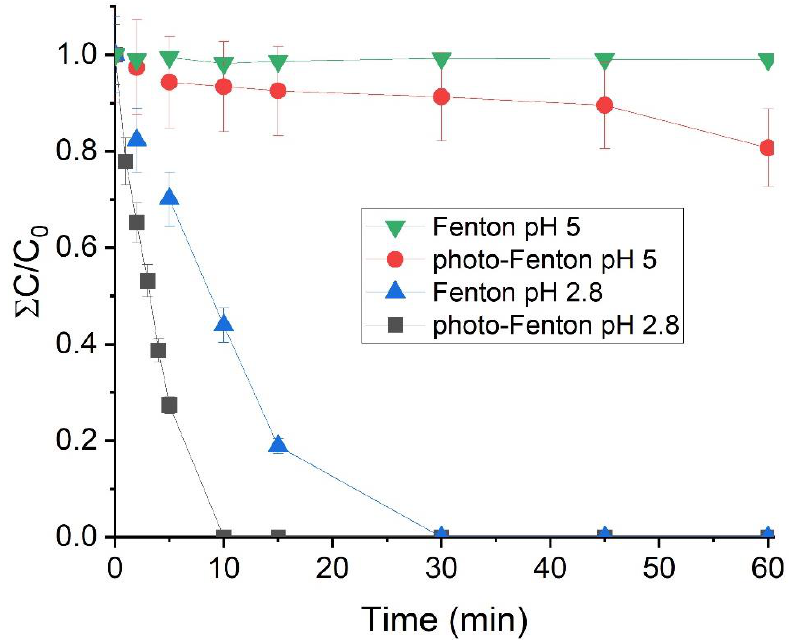
Figure 1. Paraben degradation by Fenton and photo-Fenton processes at optimal pH 2.8 and at pH 5. [methylparaben] = 5 mg · L − 1 , [ethylparaben] = 5 mg · L − 1 , [propylparaben] = 5 mg · L − 1 , [butylparaben] = 5 mg · L − 1 , [benzylparaben] = 5 mg · L − 1 , [H 2 O 2 ] = 26.8 mg · L − 1